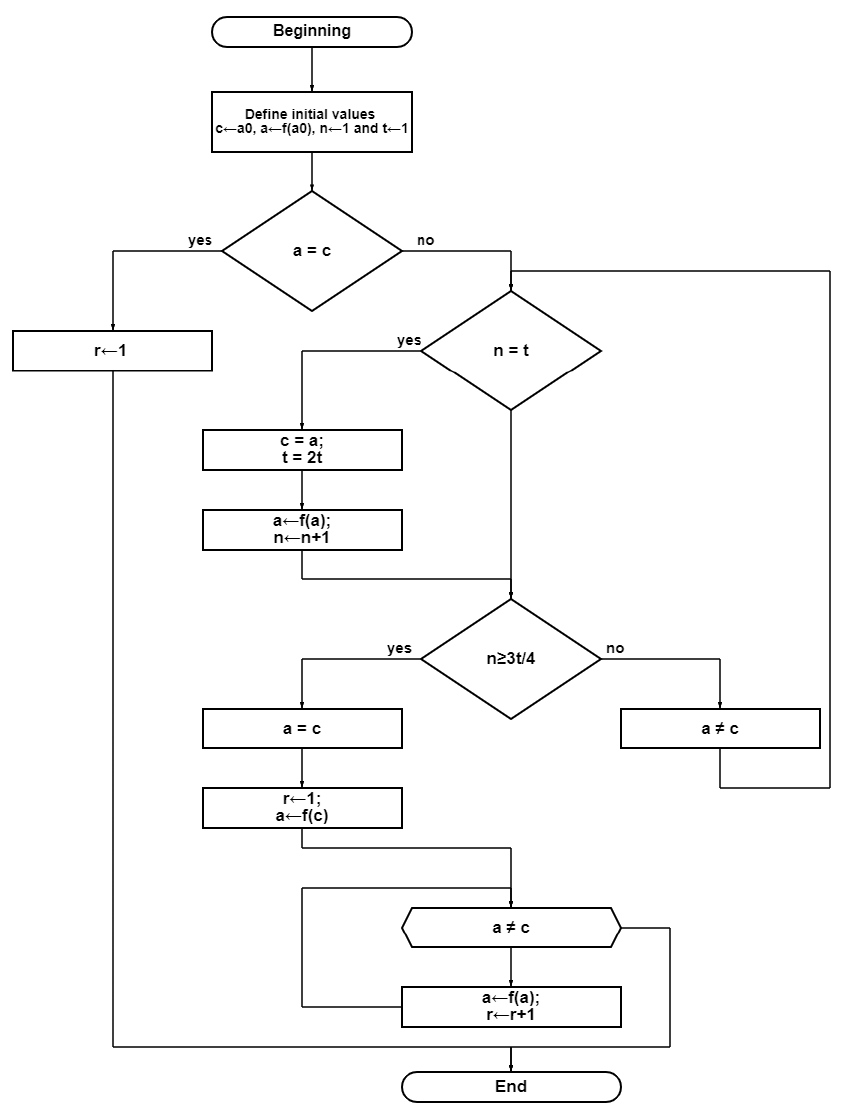
Figure 4. Block diagram of the Brent method .